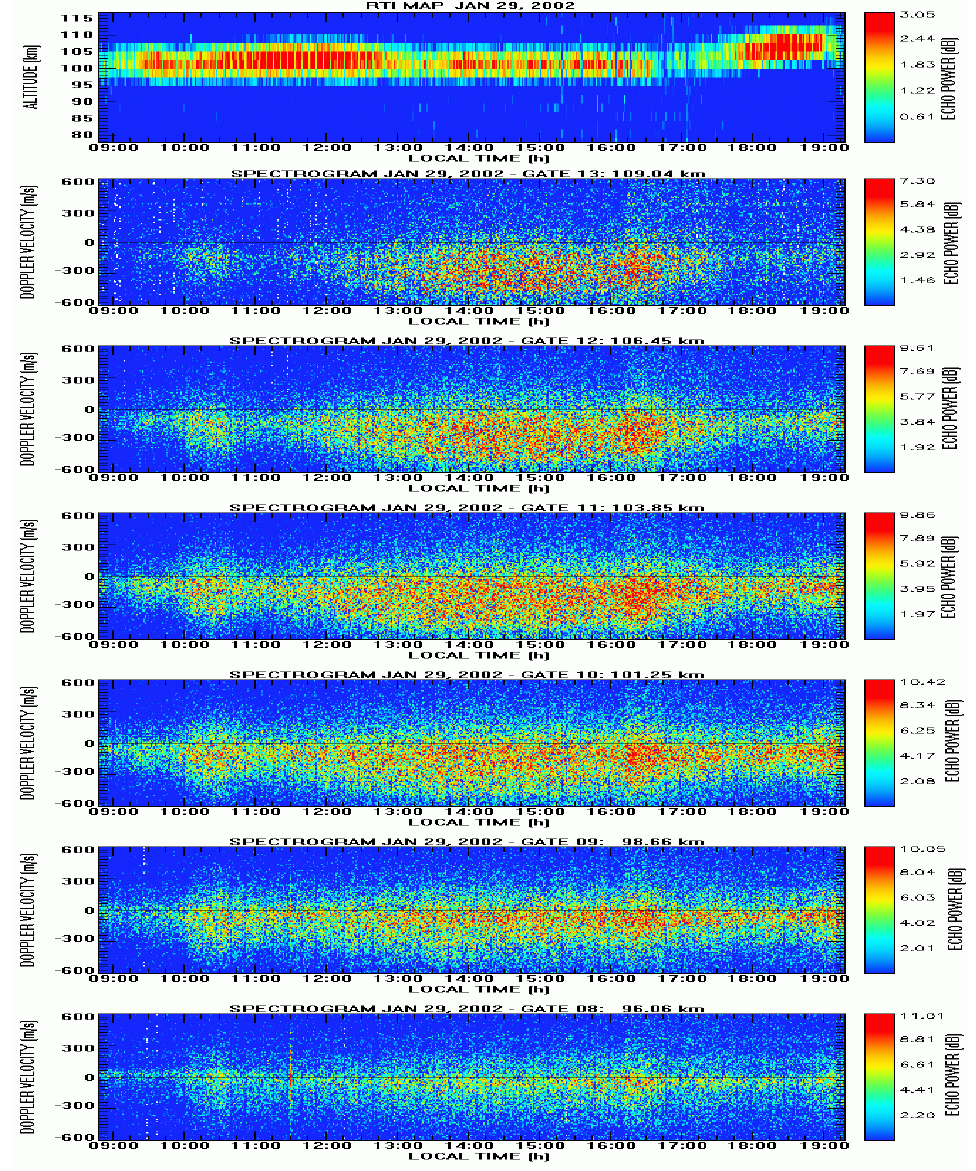
Fig. 3. Upper panel: RTI map from 29 January 2002 with its corresponding spectrograms (from bottom to top) for the center heights 96.0, 98.6, 101.2, 103.8, 106.4 and 109.0 km. The color scale beside each map gives the corresponding signal power in dB. Figure 3. Upper panel: RTI map from January 29, 2002 with its corresponding spectrograms (from bottom to top) for the center heights 96.0, 98.6, 101.2, 103.8, 106.4 and 109.0 Fig. 4 is a true representation of the E -region after about of the electron density profiles vis-`a-vis the irregularity trace leads us to infer that the Type II irregularities observed by 18:00 LT we may conclude that these irregularities are gen- km. The color scale beside each map gives the corresponding signal power in dB. RESCO must indeed have been generated at the positive (up- erated through the gradient-drift mechanism, which requires ward) density gradient region just below the E -layer elec- the electric density gradient to be parallel to the electric field tron density peak. The subsequent ionograms (not shown (both being upward in this case). The generation of the post here) indicate an ascent of the F -layer trace until close to 18:00 LT, scattering region (for the Type II irregularities) re- 19:00 LT, when spread-F started to be observed and impairs quires an intensification of the E -region vertical (upward) the ionogram reading. electric field E L that should originate from a correspondingly enhanced eastward electric field E ϕ